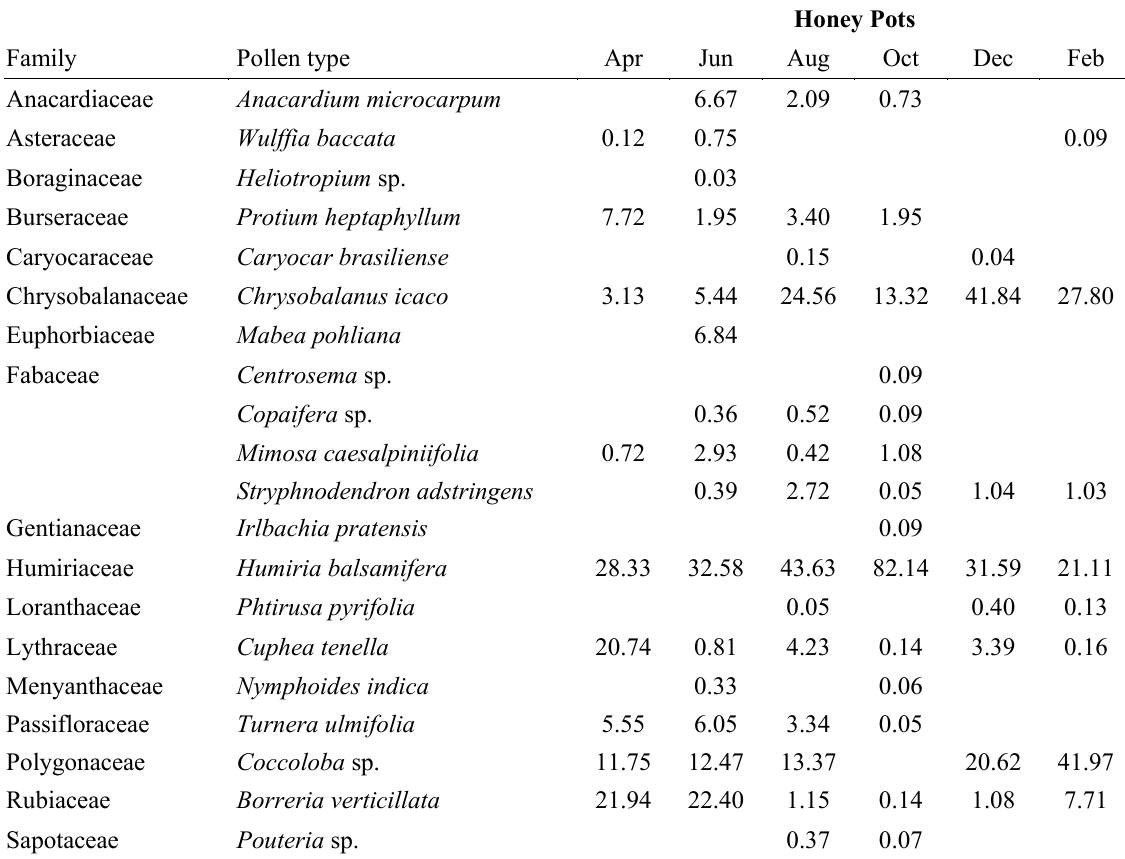
Table 2 . Frequencies (%) of pollen types of nectariferous species from honey samples produced by Melipona subnitida in a restinga area, Maranhão state,